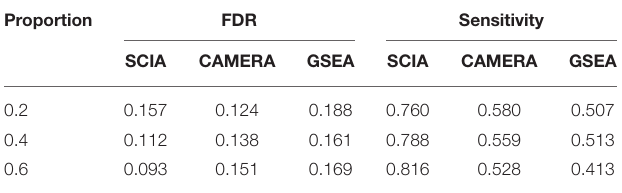
TABLE 4 | SCIA has higher sensitivity than the competitive methods under different percentages of DEGs in background genes.